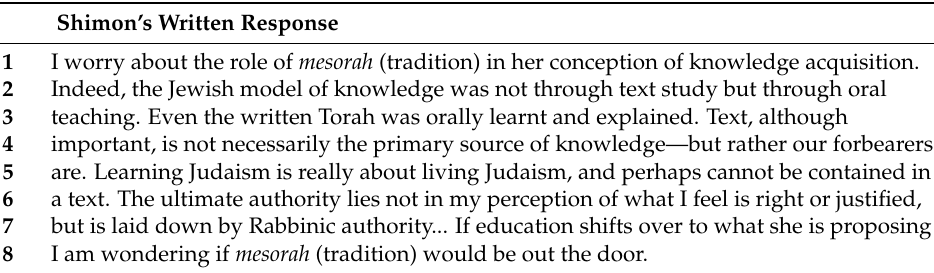
Table 1. Shimon’s